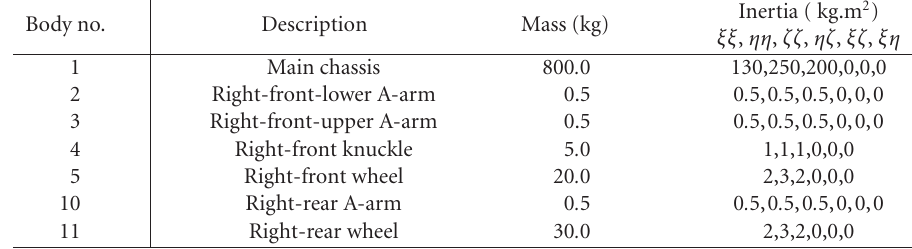
Table 2.1. Description of the rigid bodies.